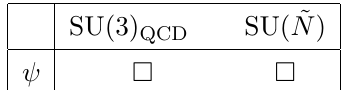
Table 1 . The messenger (cid:12)eld between the SM QCD and the SU( ~ N ) con(cid:12)ning exotic group. mass of the dynamical axion. 3 This is an interesting result, which invites further study of the phenomenology of these